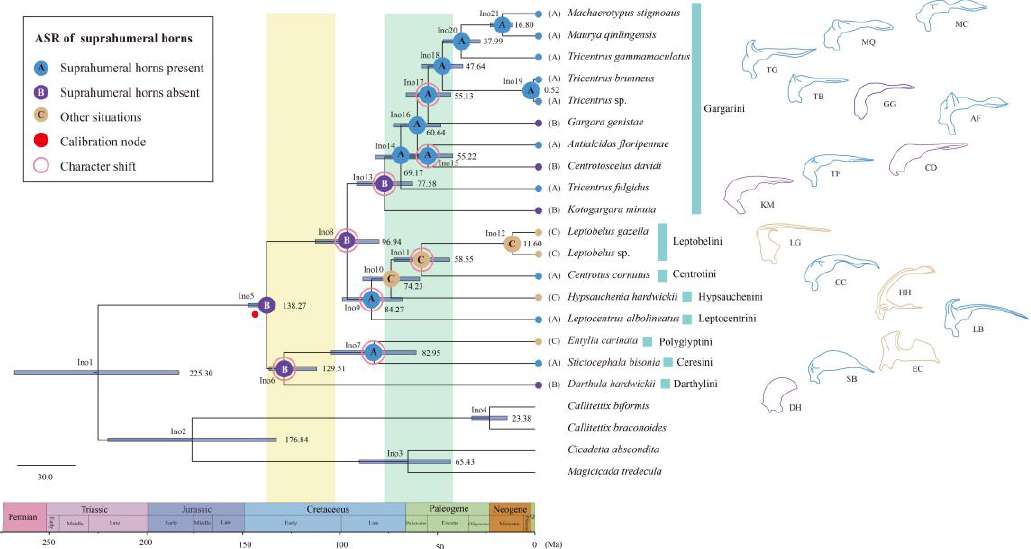
Figure 6. Chronogram showing the ancestral state reconstructions and temporal divergences of treehopper. Pie charts on nodes indicate most likely states only. Blue bars indicate time intervals for 95% probability of actual age (Table S6). The color of nodes at the end of the tree and the color of letters in brackets correspond to states of treehopper suprahumeral horn on the left box of the figure. The figure on the right is the lateral view sketch of pronotum of the treehoppers. Calibration nodes by the red dot. Character shift by pink circles.